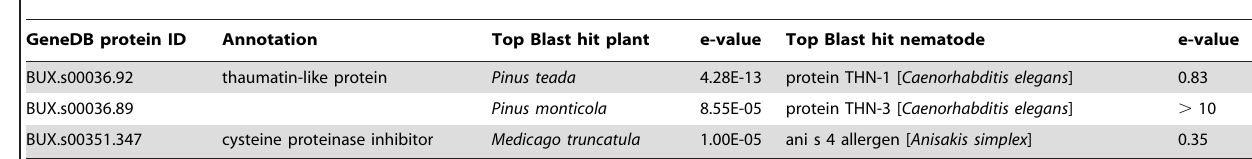
Table 6. Potential molecular mimicry proteins against host plants in Bursaphelenchus xylophilus